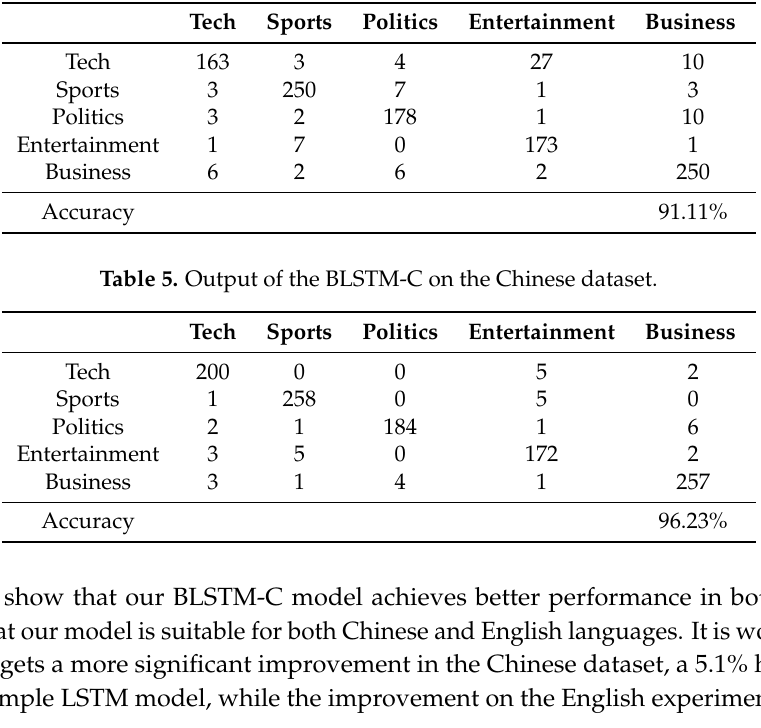
Table 4. Output of the simple LSTM on the Chinese dataset.